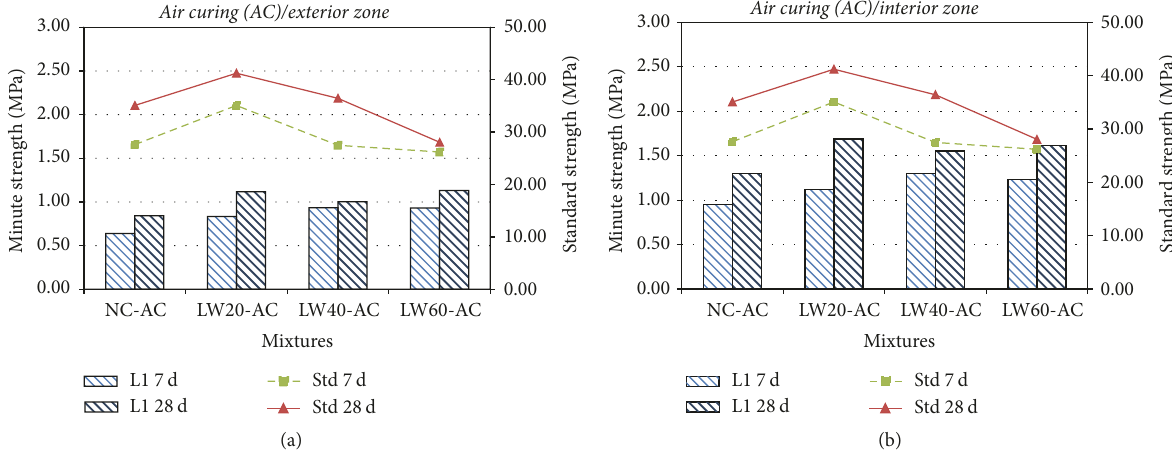
Figure 15: Relationship between standard and minute compressive strength of dry-air curing regime at (a) exterior zone and (b) interior zone.